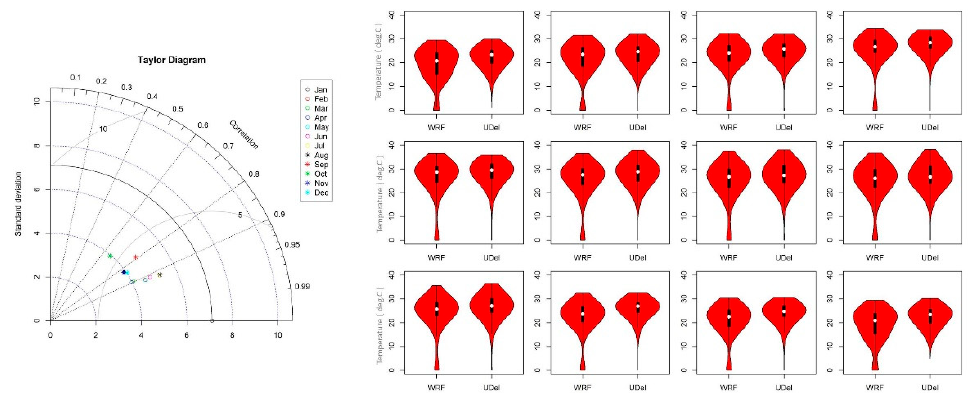
Figure 7. Taylor diagram showing the correlation coefficients, the RMSEs, and the standard deviations of the simulated average surface air temperatures and those from the UDEL dataset each month as well as violin plots for the average surface air temperature each month over the ENB region.